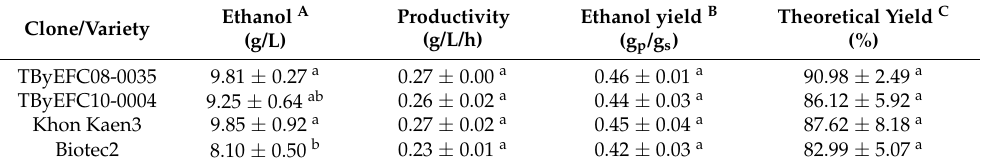
Table 5. Ethanol production by Sch. shehatae TTC79 from bagasse of energy cane clones and control varieties.